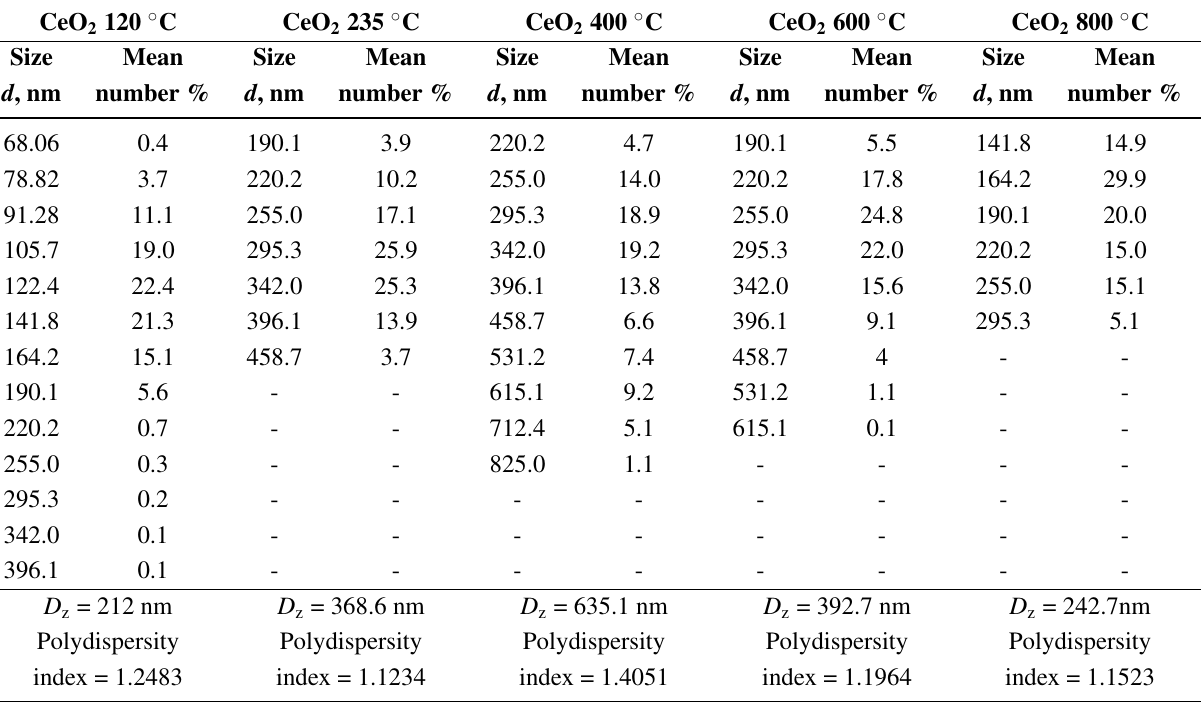
Figure 6. Size distribution of CeO 2 thermally treated at different temperatures. Table 1. Particle size distribution of the as-prepared CeO 2 powders.